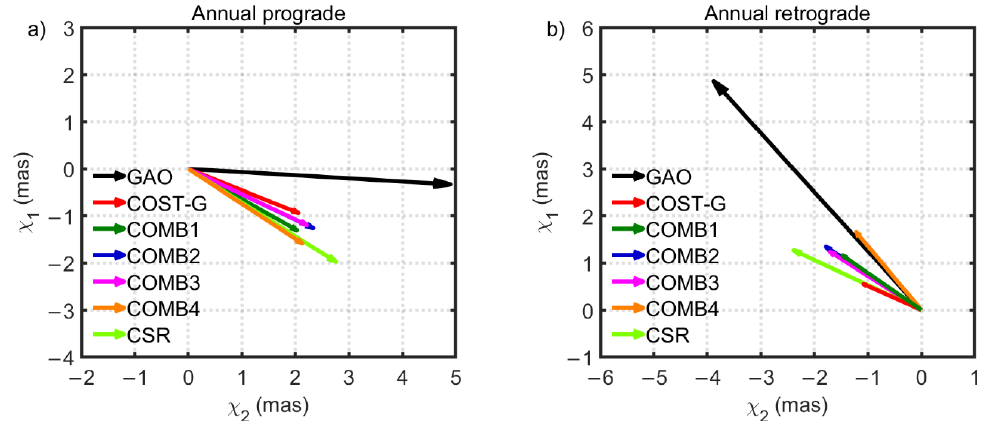
Figure 8. Phasor diagrams of the annual prograde ( a ) and annual retrograde ( b ) variation in complex series (χ 1 + iχ 2 ) of gravimetric excitation and GAO. Phase (φ) is defined by the annual term as sin(2π(t − t 0 ) + φ), where t 0 is the reference epoch (1 January 2004). The similar phasor diagrams drawn for semiannual prograde and semiannual retro- grade oscillations show that the semiannual retrograde variation is very weak for both GAO and gravimetric excitation (Figure 9). The results for COMB solutions are congru- ous; the amplitude differences with respect to GAO are between 1.33 and 1.47 mas for the prograde term and between 0.41 and 0.45 mas for the retrograde term, while the phase discrepancies are as high as 37° – 40° and 56° – 63° for the prograde and retrograde oscilla- tion, respectively. Since the amplitudes of terannual oscillations turned out to be very small (Figure 4), they are not analysed in our study.